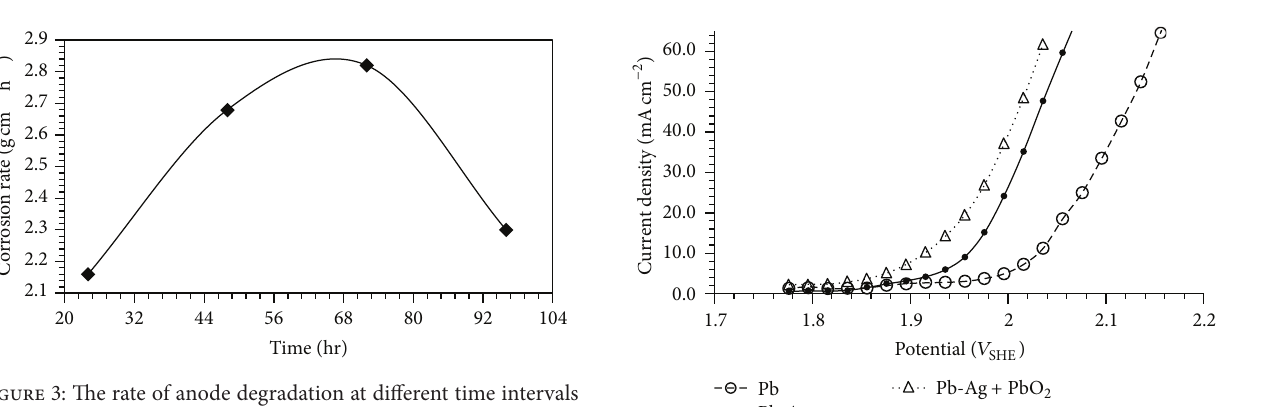
Figure 3: The rate of anode degradation at different time intervals during the electrowinning process, obtained at current density 500 A/m 2 via mass-loss measurements ( 𝑇 = 40 ∘ C).